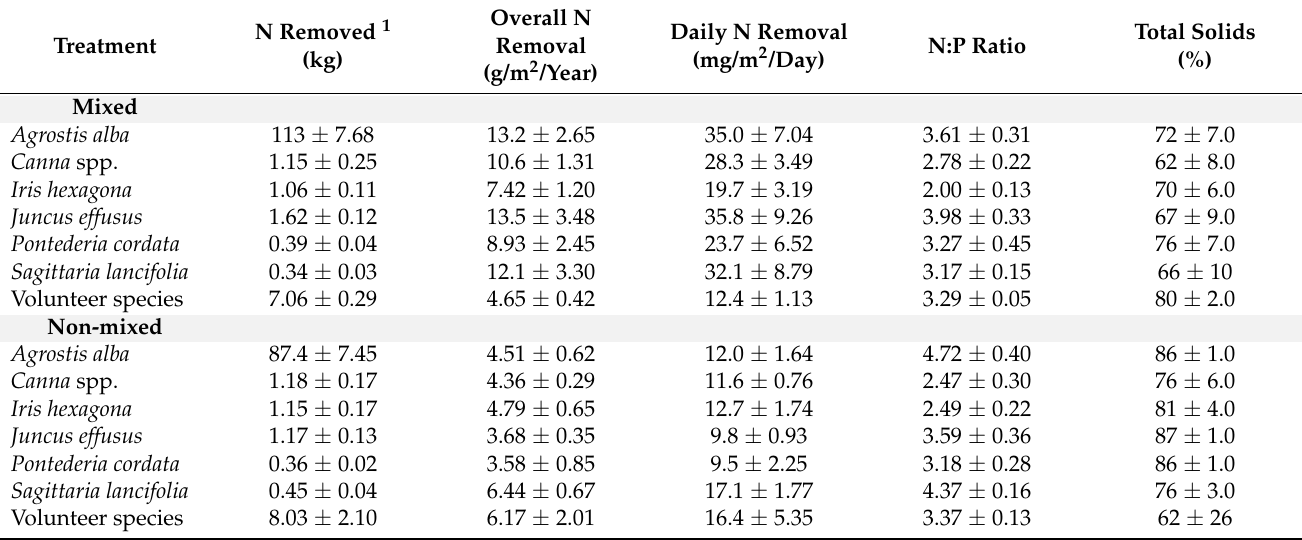
Table 2. Total nitrogen (N) removed at harvest in April 2019, yearly and daily N removal rate per m 2 of floating treatment wetland, N:P ratio (by mass), and percent total solids by treatment and plant species.